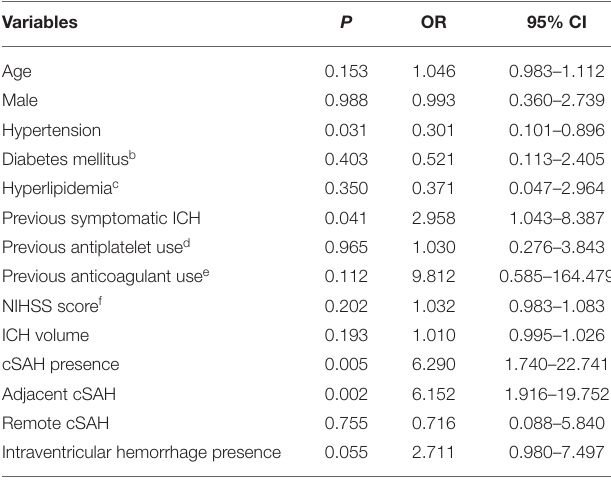
TABLE 4 | Univariate regression analysis of factors for recurrent ICH within 90 days a .